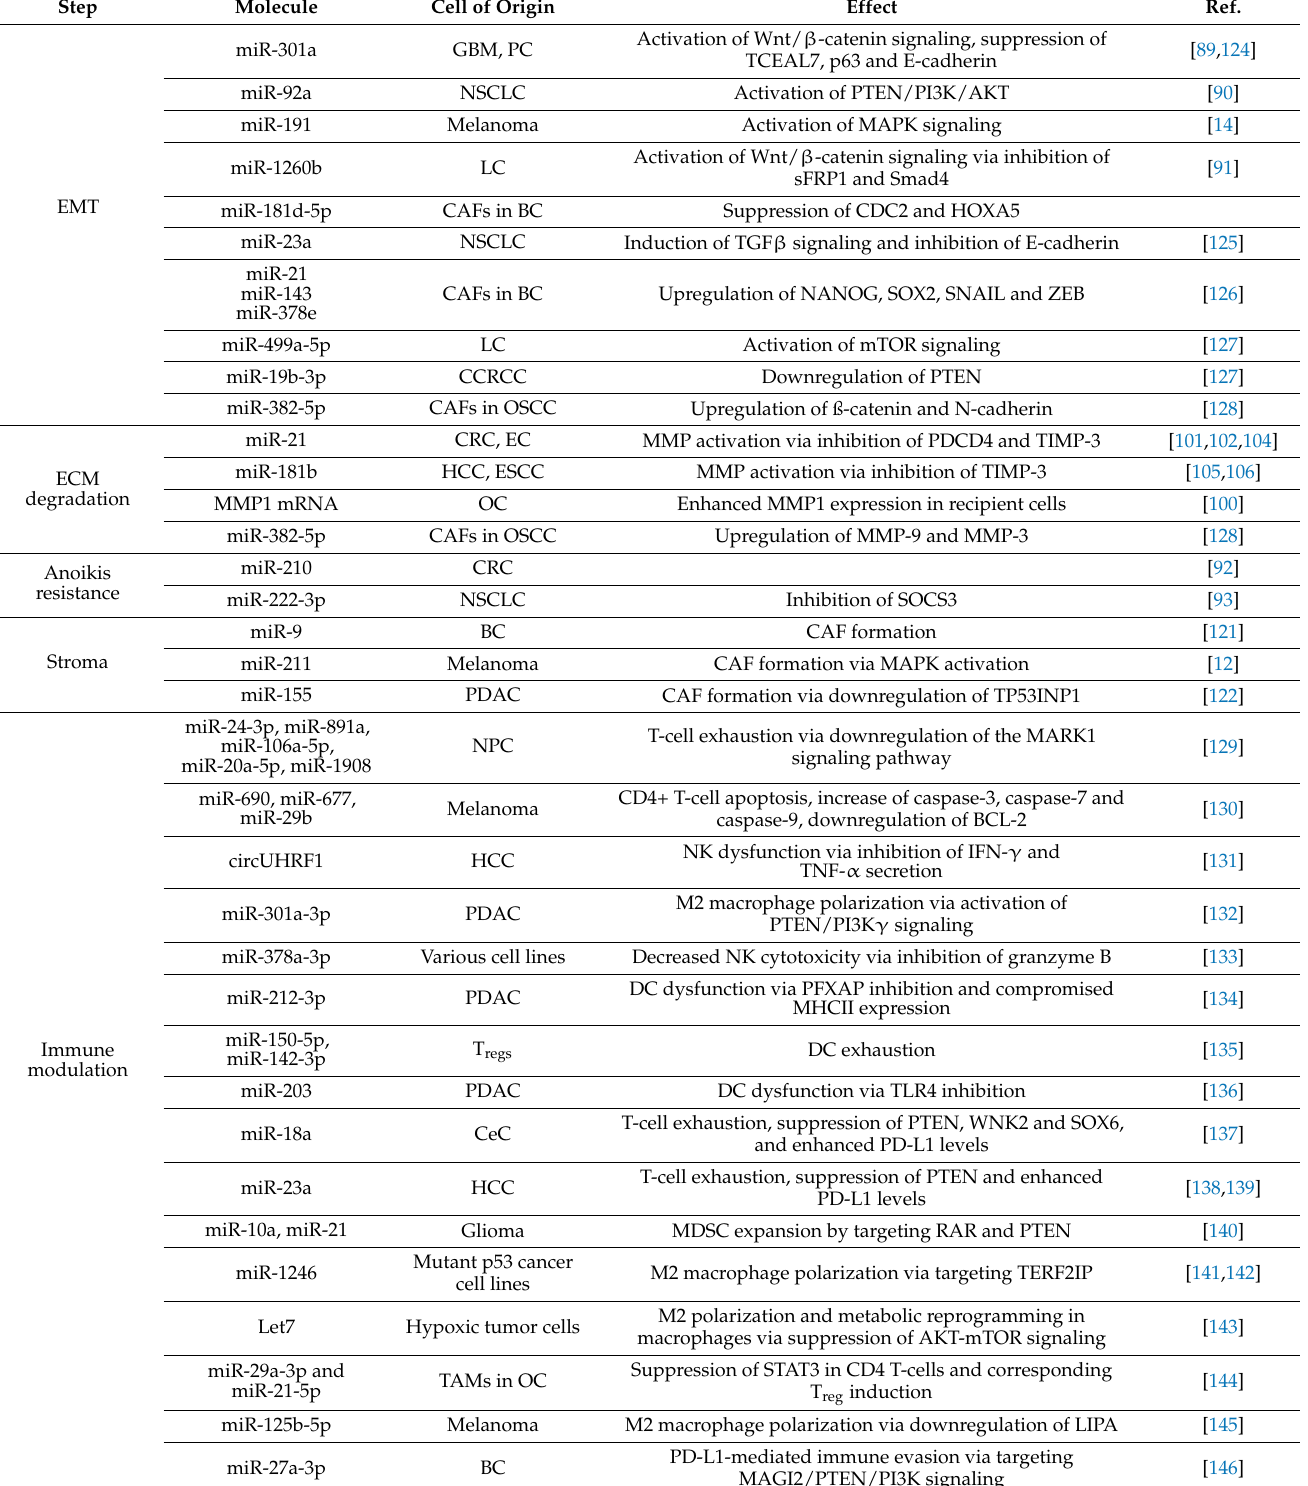
Table 1. Origin and biological effects of sEV-derived